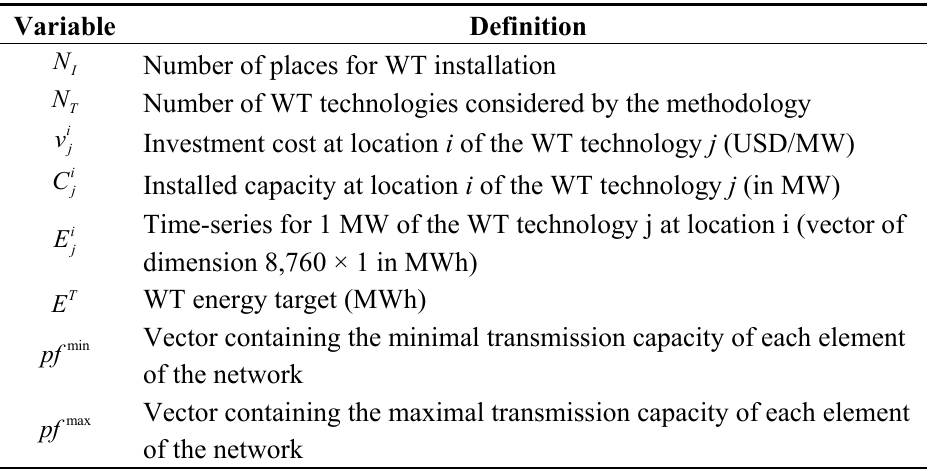
Table 1. Variables